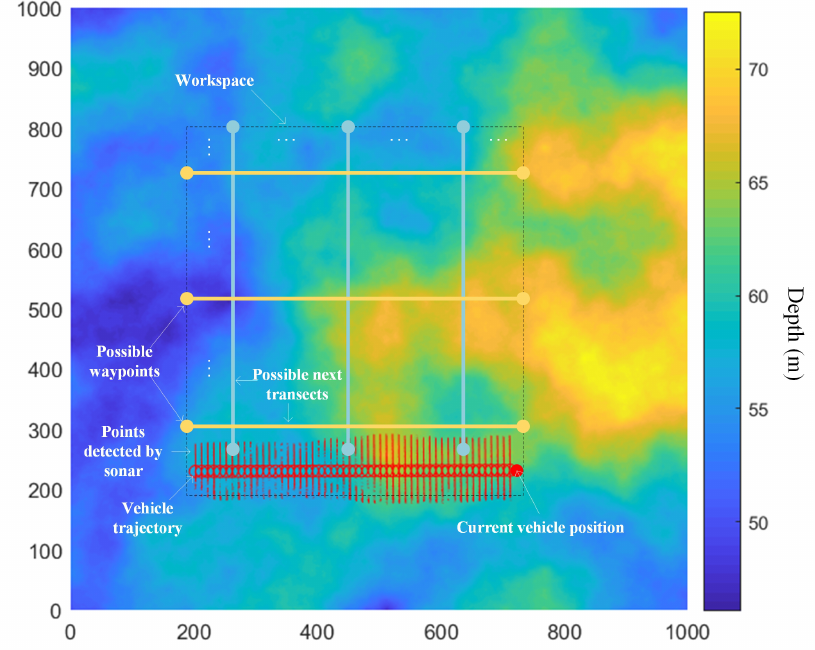
Figure 2. The conception of the proposed CPP method. The vehicle will plan the successive pair of waypoints after one transect is finished. Different colors of the terrain represent different depths, as illustrated in the